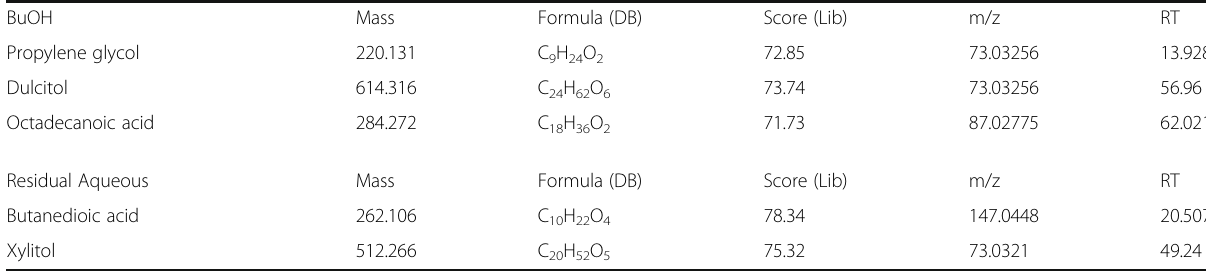
Table 3 Identified metabolites in methanol extract and its different fractions (Continued) BuOH Mass Propylene glycol